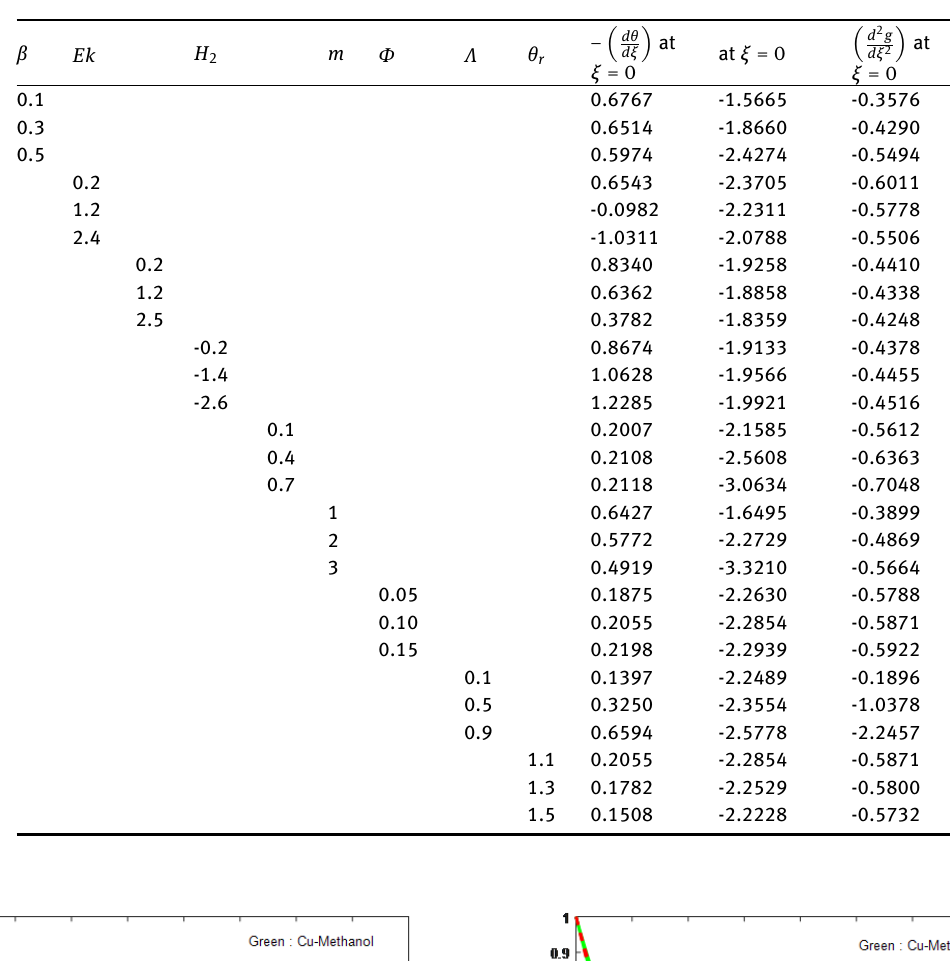
(cid:16) (cid:17) (cid:16) d 2 f (cid:17) (cid:16) d 2 g (cid:17) , , at ξ = 0 reckoned utilizing Eqs. (13)-(15), for Al-Cu-methanol liquid flow dθ dξ dξ 2 dξ 2